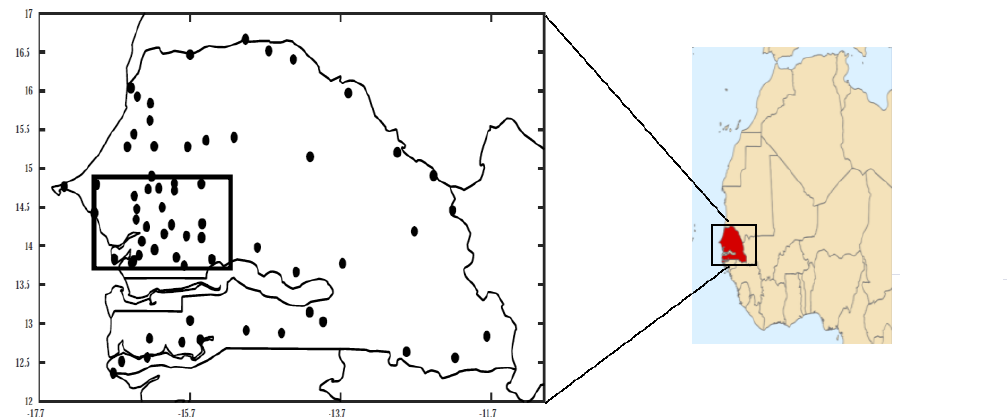
Figure 1. Map of Senegal and West Africa (inset). The black dots indicate the location of the 65 ANACIM rain gauges used in this study. The square in central-western Senegal denotes the location of the peanut basin (area of high density of rain gauges).